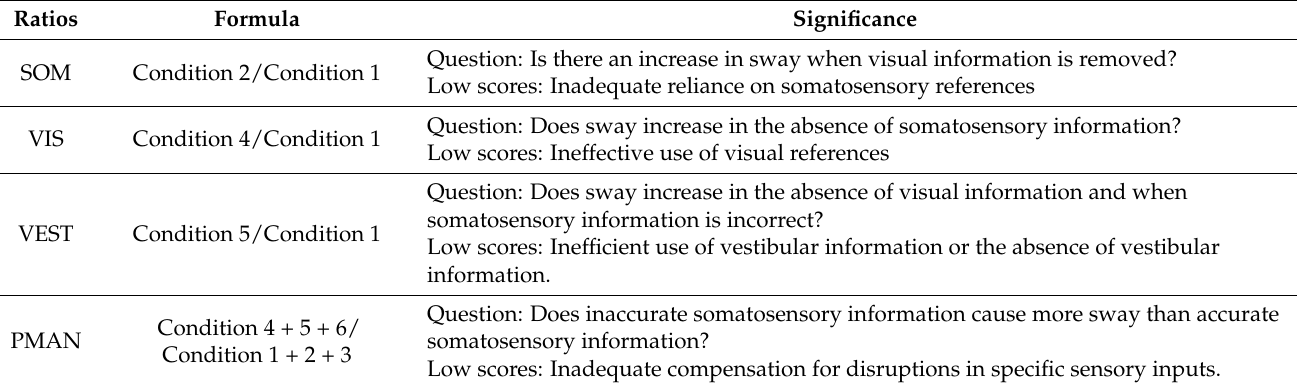
Table 3. Descriptions of sensory analysis [42].